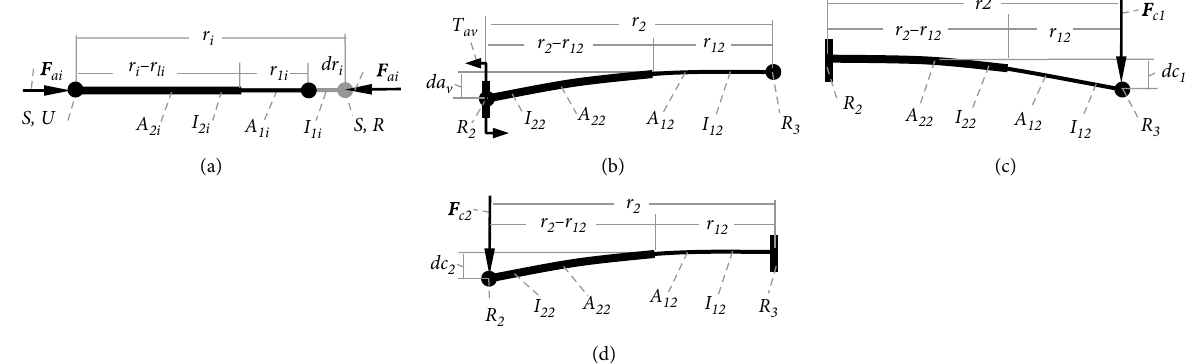
, and 𝑇 𝐹 𝑐 v 𝑎𝑖 𝑐𝑗 ,